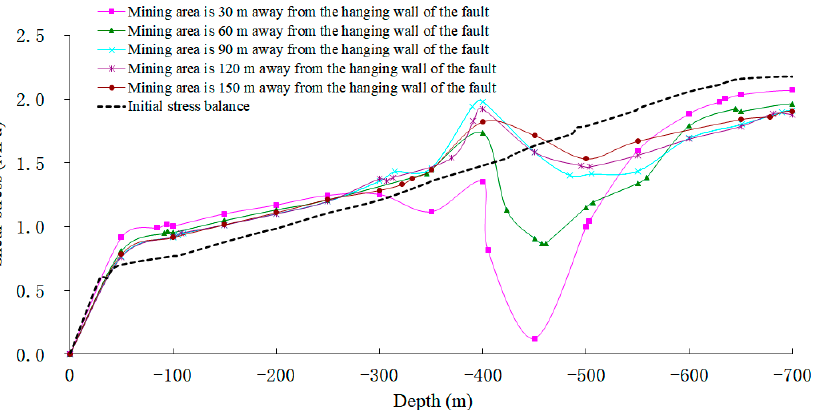
Figure 6. When the mining area is situated within the fault hanging wall, the shear stress distribution on the fault plane is at various locations.